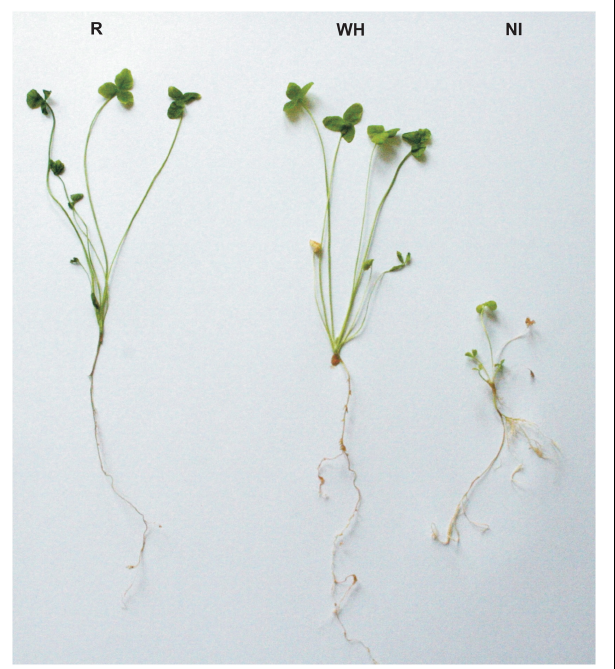
FIGURE 2 | The growth habit of Trifolium repens inoculated with R. leguminosarum bv. trifolii from the non-polluted reference Bolestraszyce area (R), the Bolesław metal-polluted waste heap area (WH), and not inoculated with rhizobia (NI).